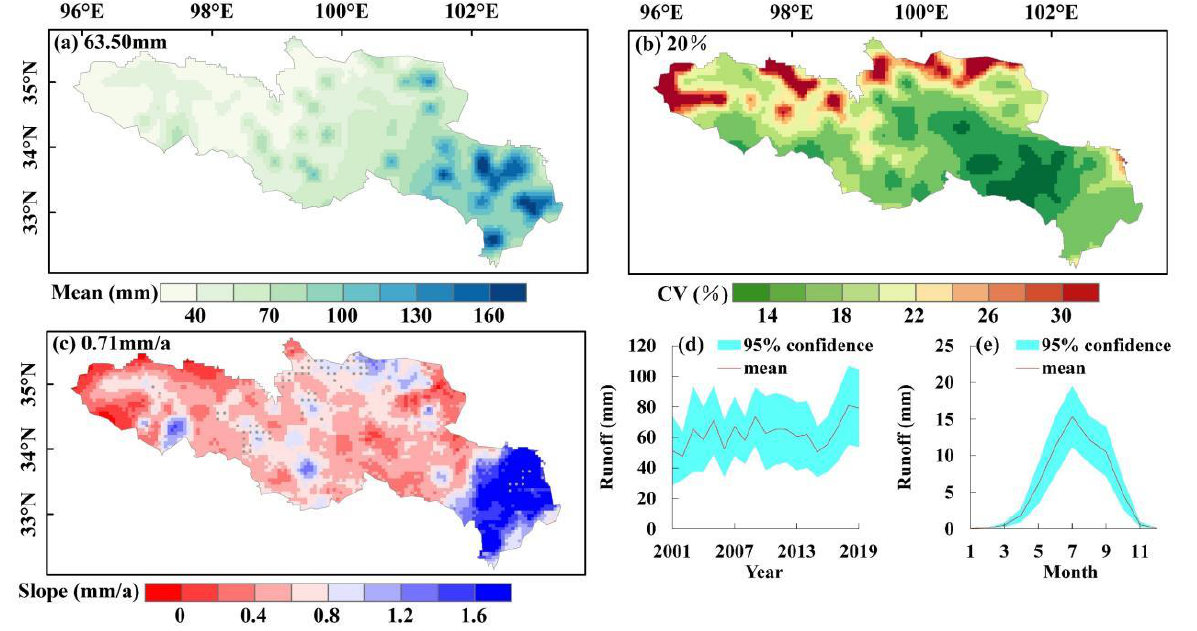
Figure 12. Annual average runoff depth ( a ), coefficient of variation ( b ), the spatial distribution of annual variation trend ( c ), annual runoff depth sequence ( d ), and monthly runoff depth variation characteristics ( e ) across the SRYR simulated using OBIPP. The OBIPP of this study is GEPC+.